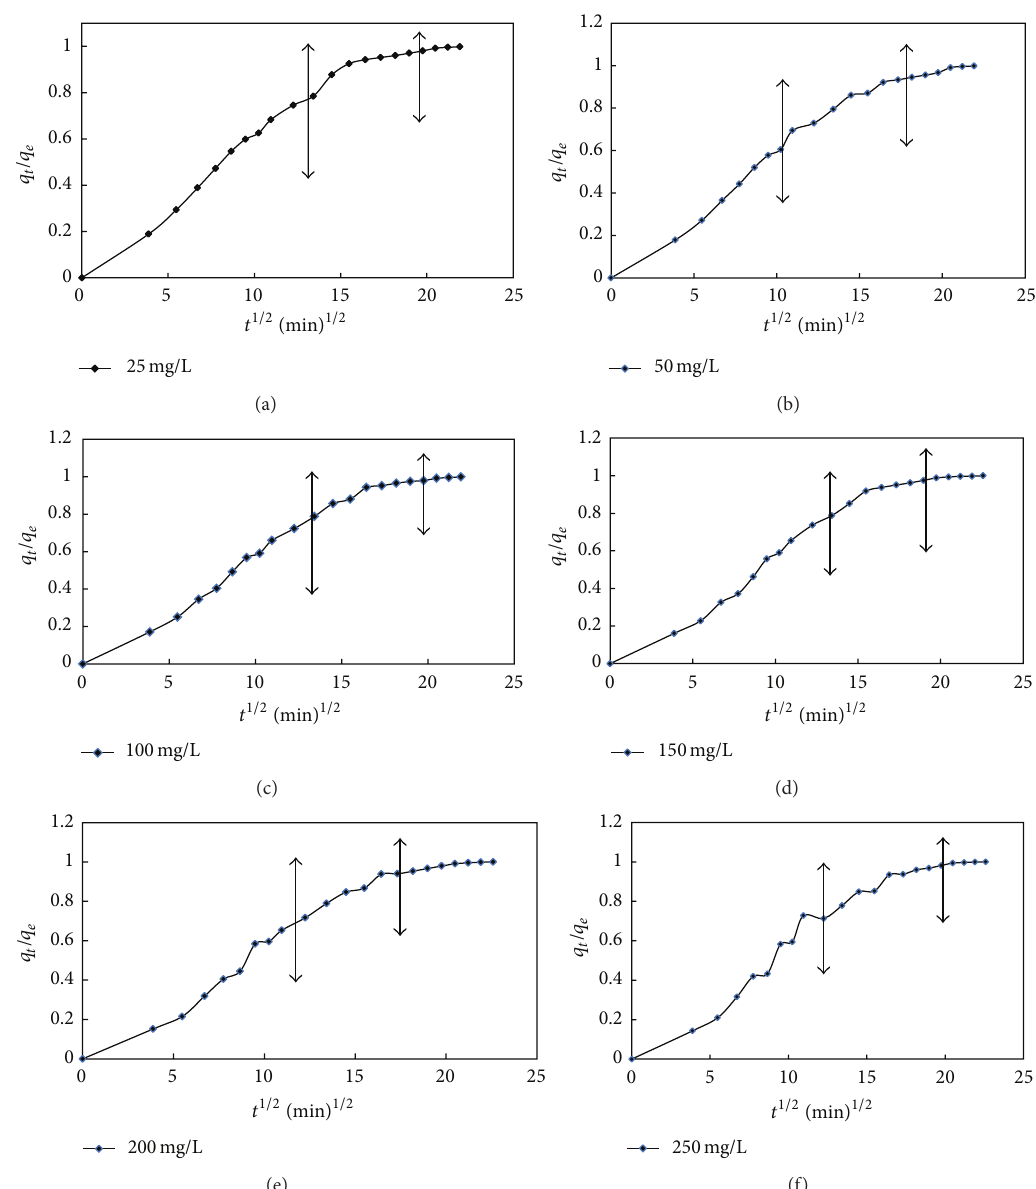
Figure 1: The plot of 𝑞 𝑡 /𝑞 𝑒 versus 𝑡 1/2 showing all three regions for adsorbent treated with HCl for the adsorption of phenol.